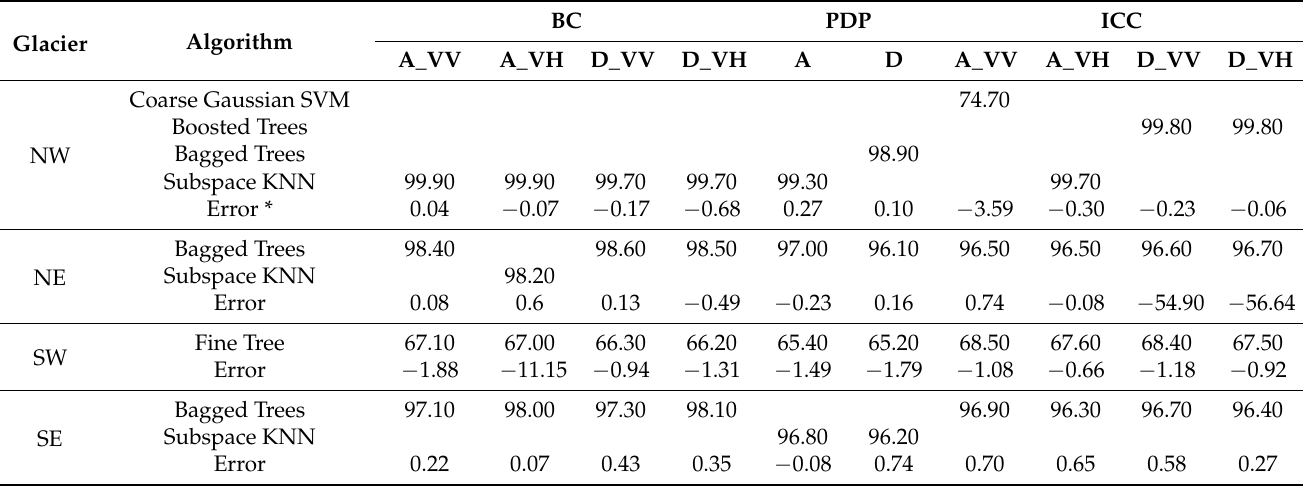
Table 4. Comparison between the overall accuracy and the prediction accuracy of the optimal model for four glaciers under different data suites.